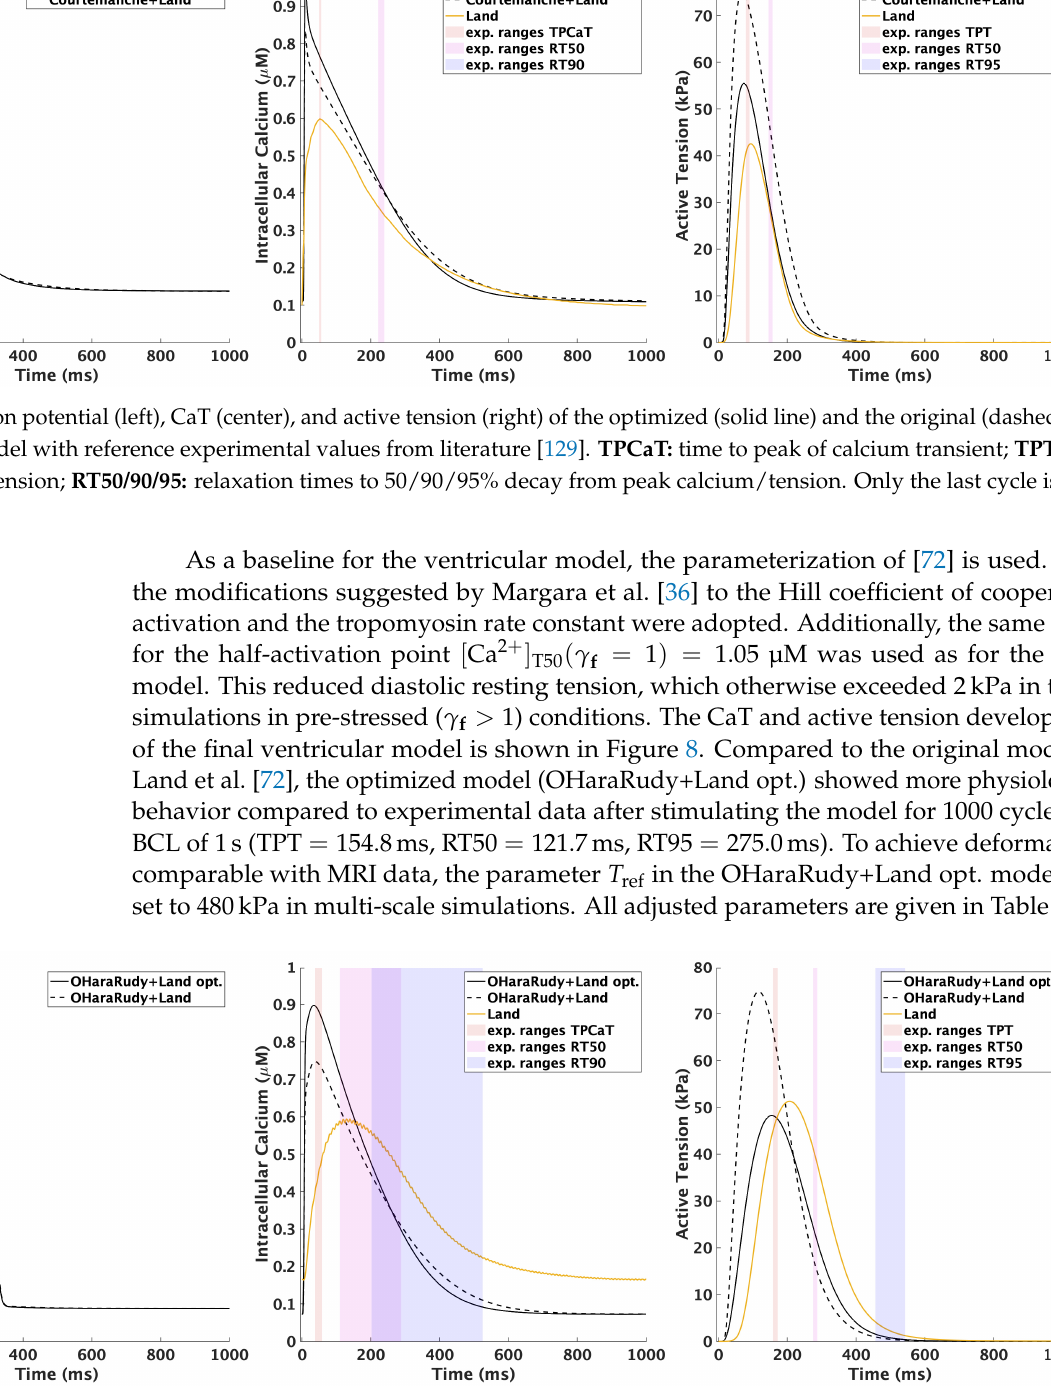
Figure 8. Action potential (left), CaT (center), and active tension (right) of the optimized (solid line) and the original (dashed line) ventricular model with reference experimental values from literature [125]. TPCaT: time to peak of calcium transient; TPT: time to peak tension; RT50/90/95: relaxation times to 50/90/95% decay from peak calcium/tension. Only the last cycle is